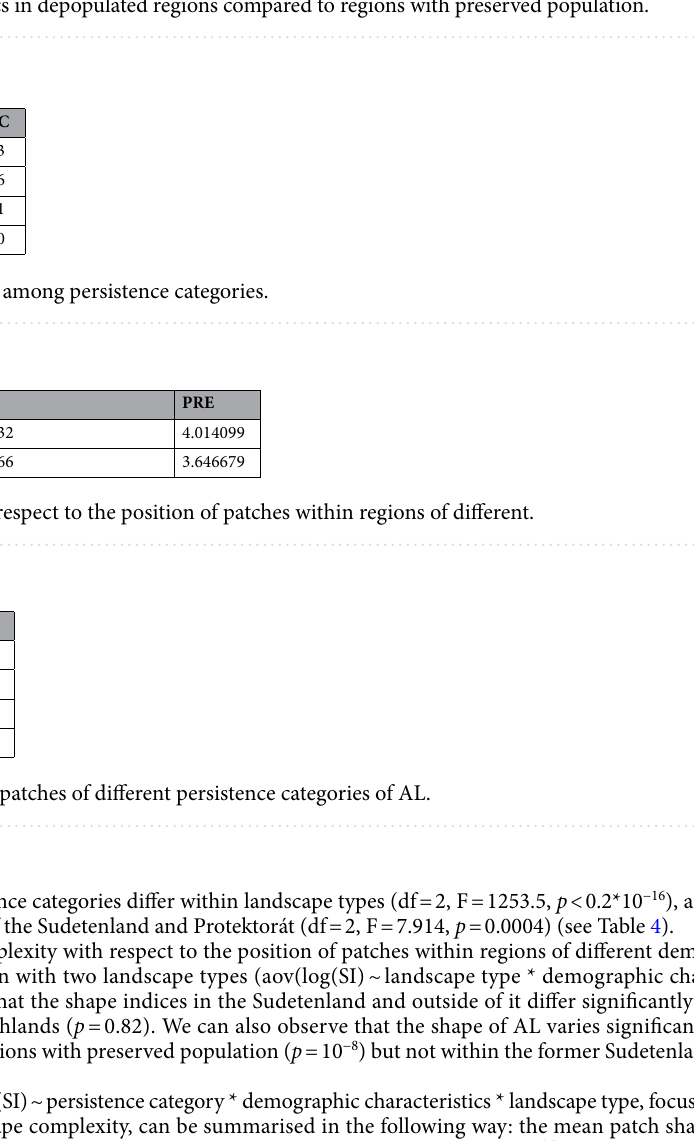
Figure 6. The level of dynamics in depopulated regions compared to regions with preserved population.